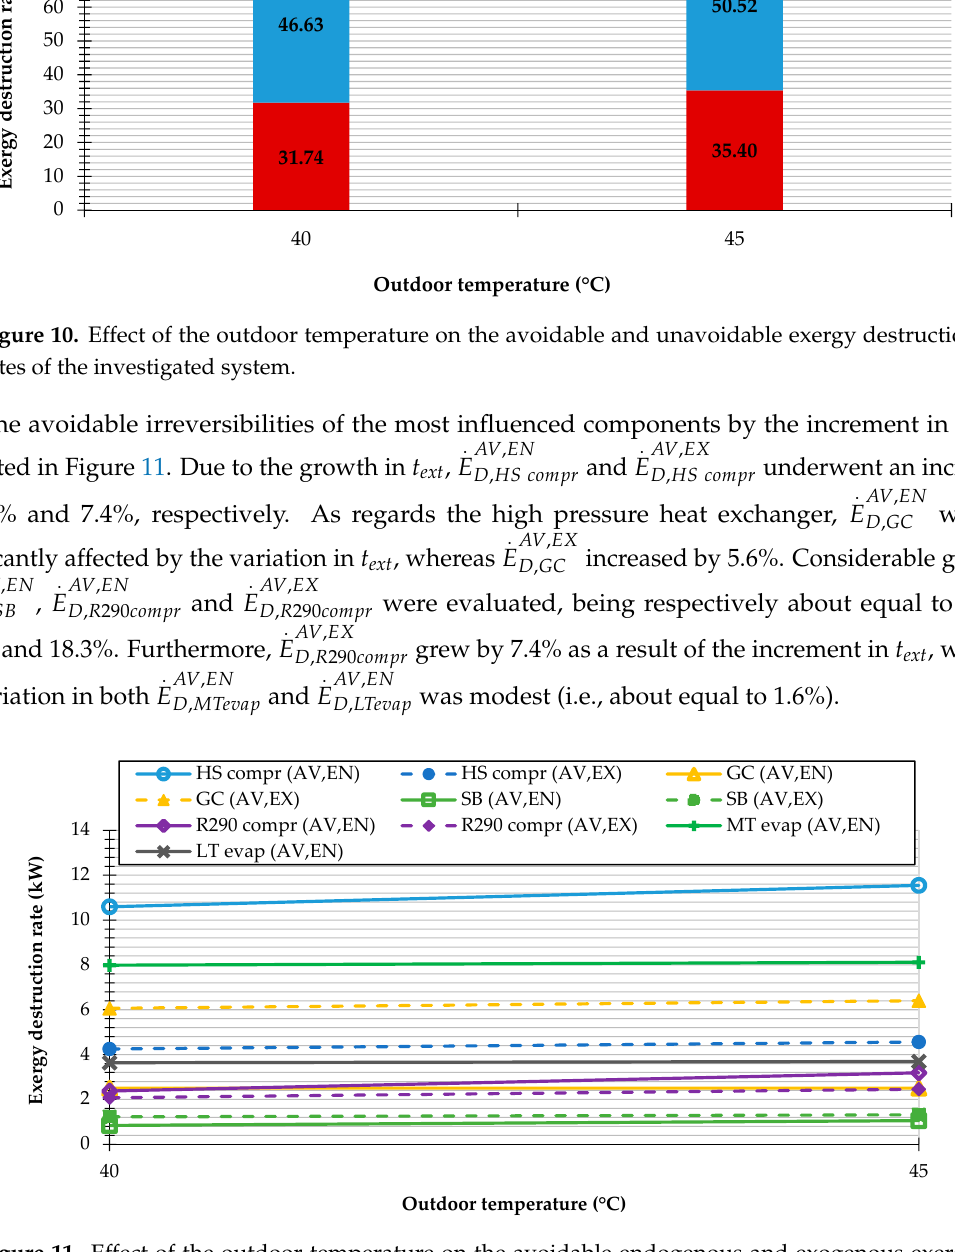
Figure 11. Effect of the outdoor temperature on the avoidable endogenous and exogenous exergy destruction rates of some selected components belonging to the investigated system.